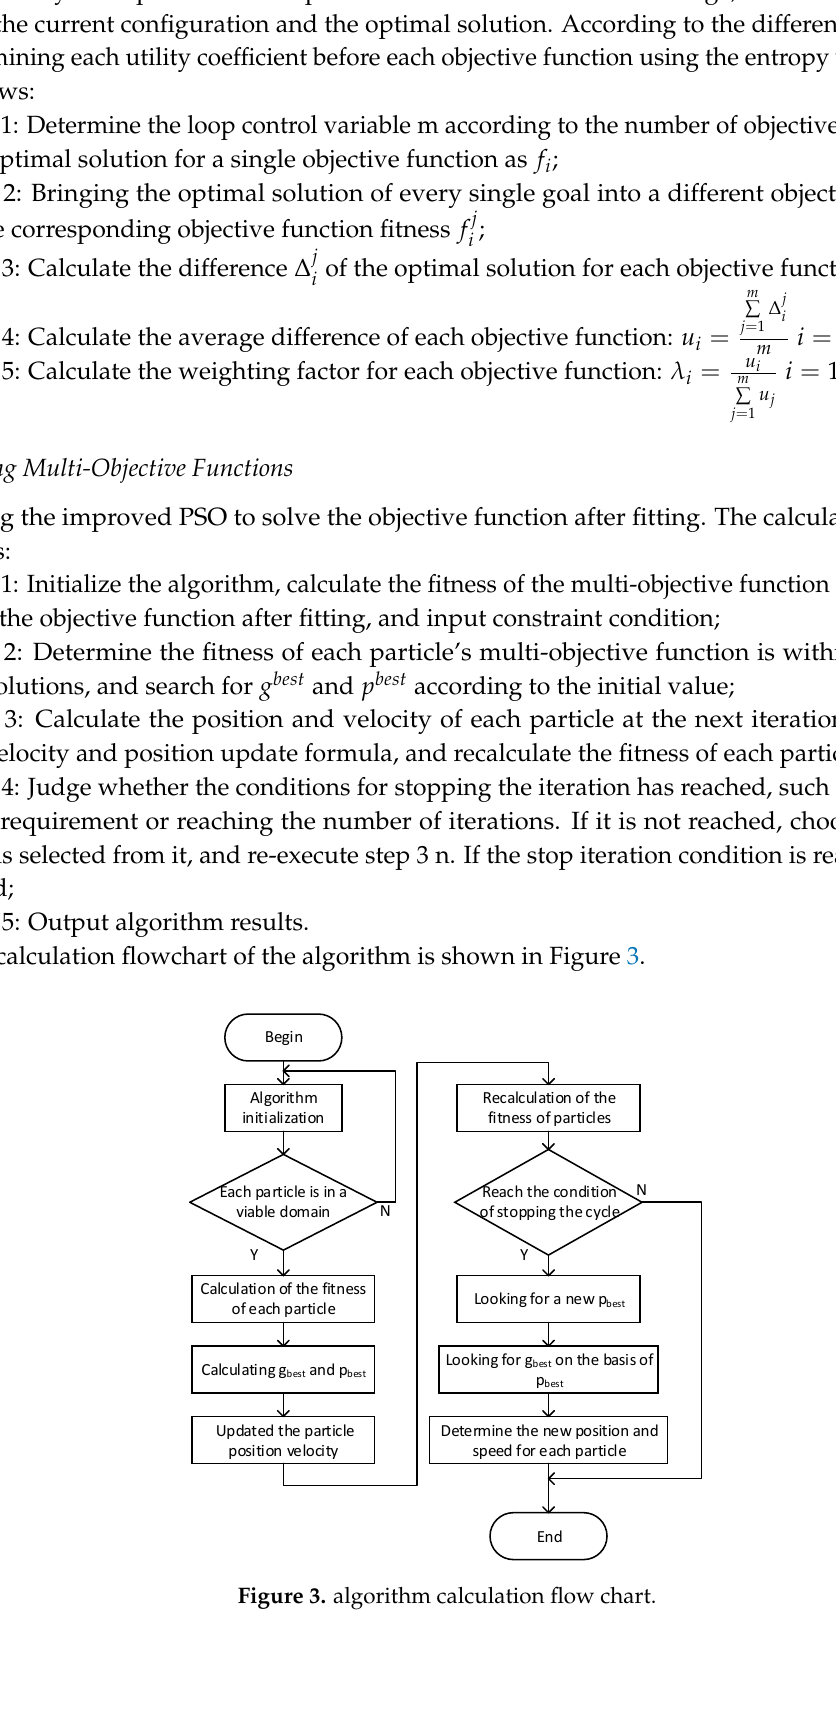
Table 1. Main parameters of the Microgrid model.